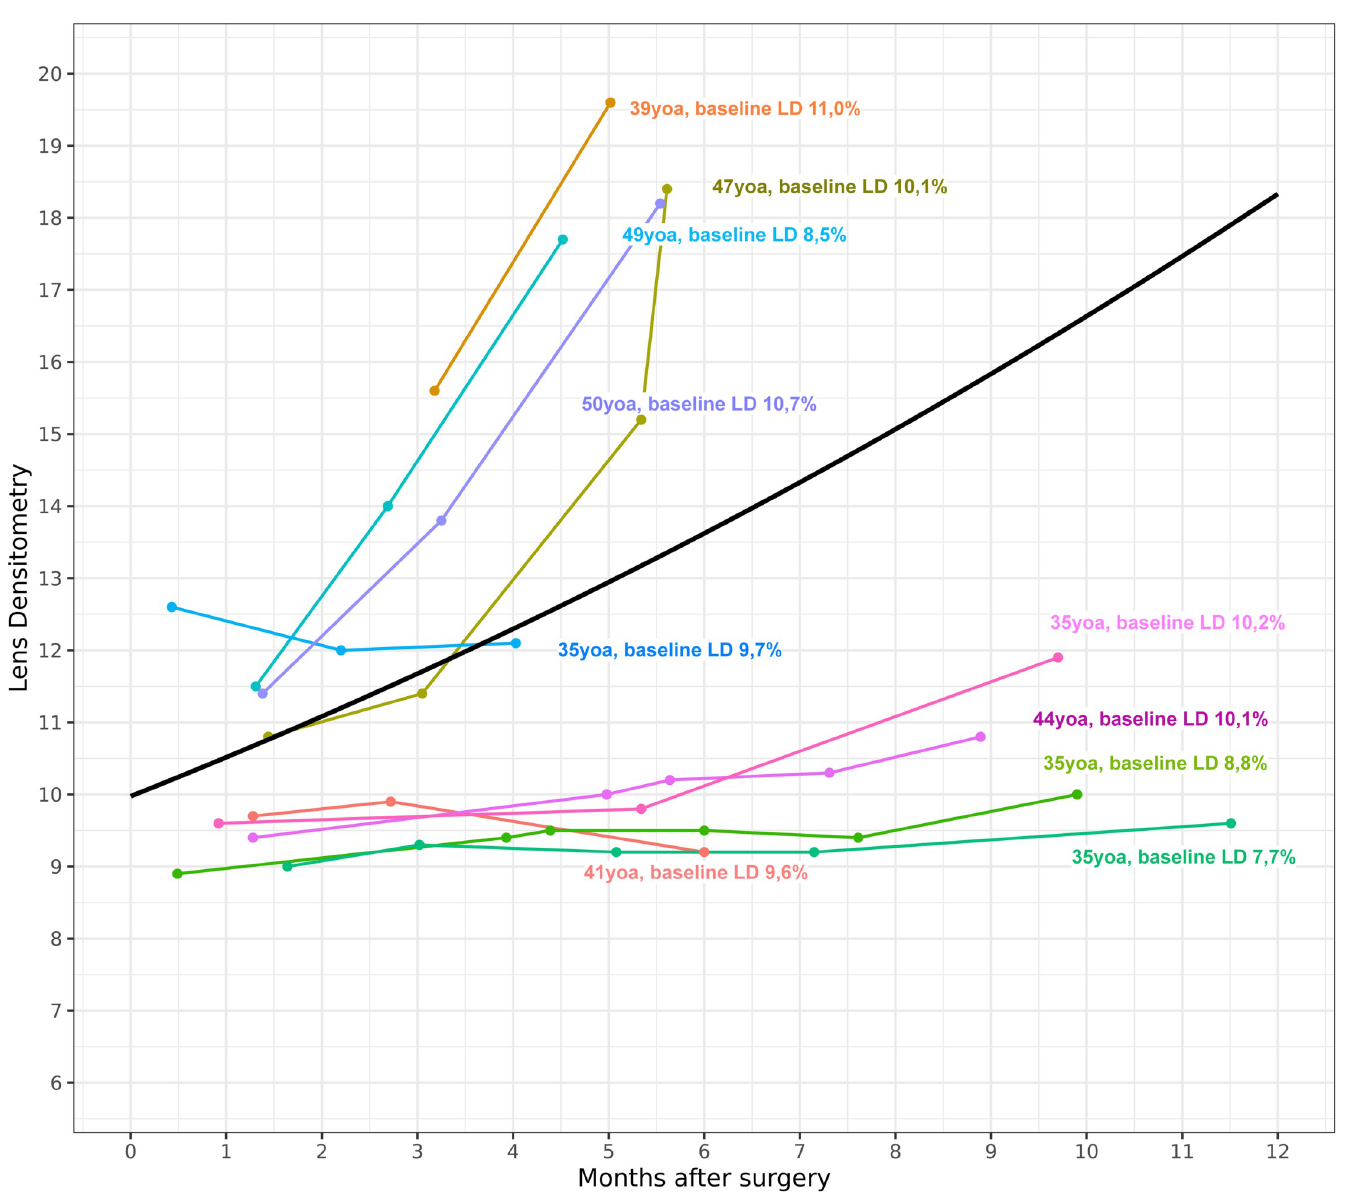
Fig 3. Observed trajectories for patients under 51 years of age (yoa). Changes in lens densitometry (%) after pars plana vitrectomy over time (months) for individual cases with younger age.